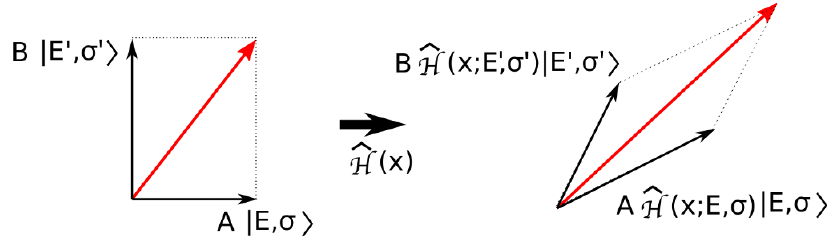
Figure 14 . When ^ H ( x ) is applied to a state made of a linear superposition of multiple basis states with di(cid:11)erent collective variables, each basis state